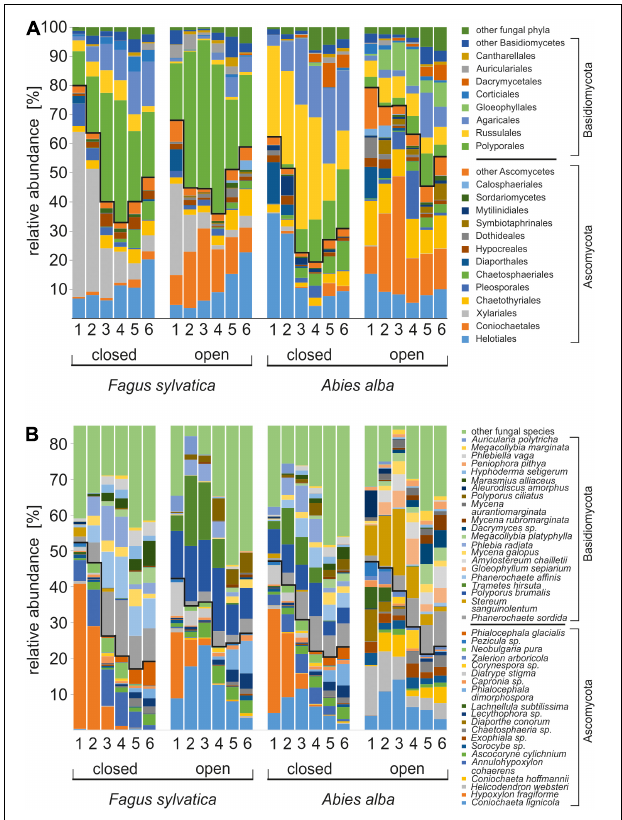
FIGURE 3 | Succession of fungi in decomposing fine beech and fir deadwoods in a natural temperate forest. The data represent the means of 16 samples per treatment for fungal orders (A) and species (B) . Fungal orders and species with average abundances over 0.5% are included. Lines separate Ascomycota and Basidiomycota.